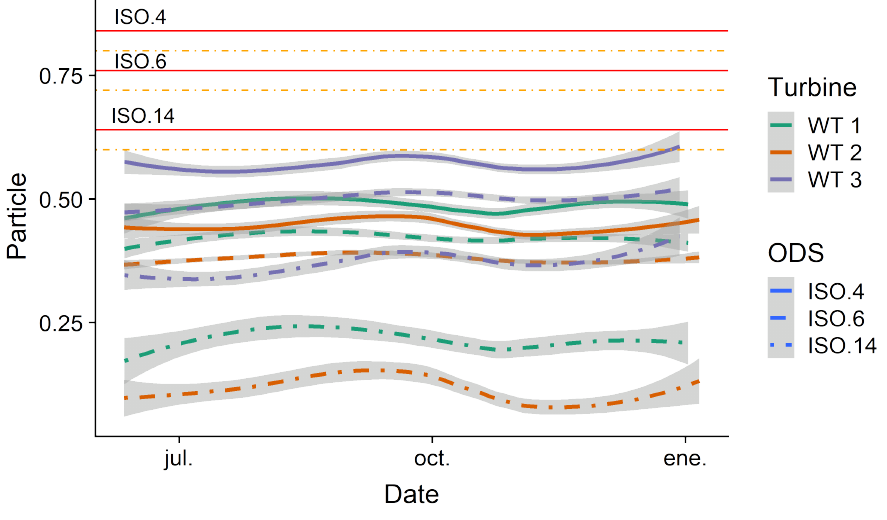
Figure 12. LOESS smoothed particle generation rates (ISO 4, 6 and 14) of Pre-ramp ORs by WT. The horizontal lines at the top represent warning and danger thresholds for the different particle